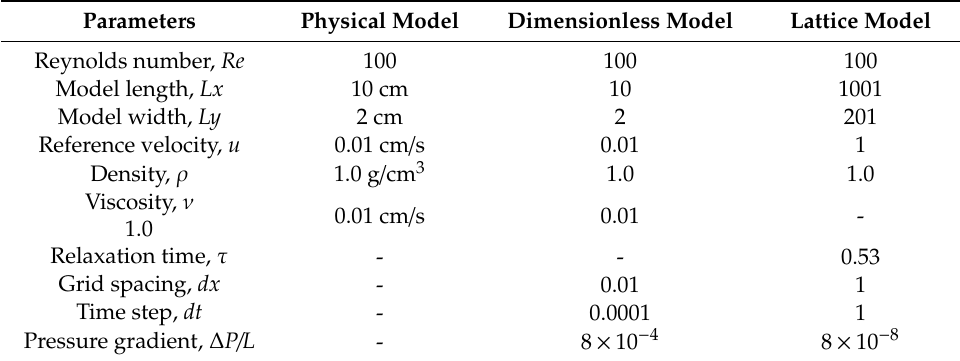
Table 1. Parameters used in the lattice Boltzmann